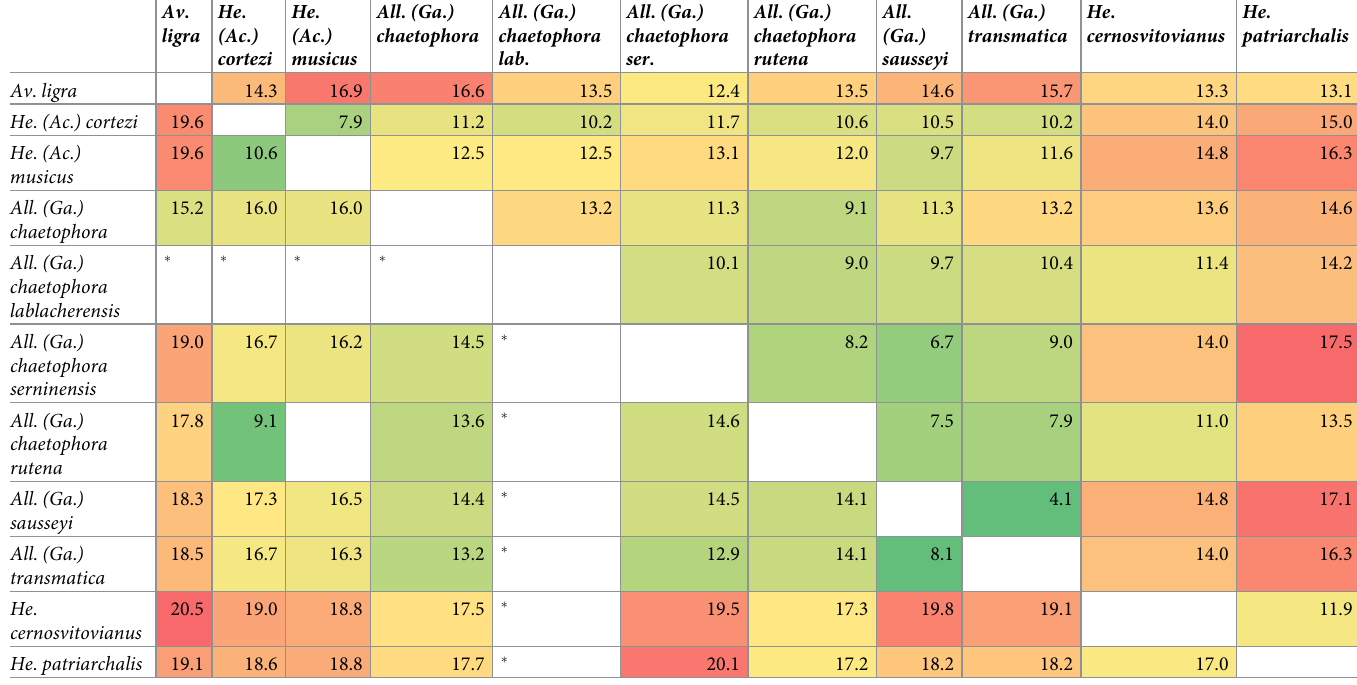
Red shading indicates higher values and green shading indicates lower values. The COI distance between All . ( Ga . ) rutena and He . ( Ac . ) musicus is not displayed as it was unusually low. Asterisks indicate COI sequences were not available for the